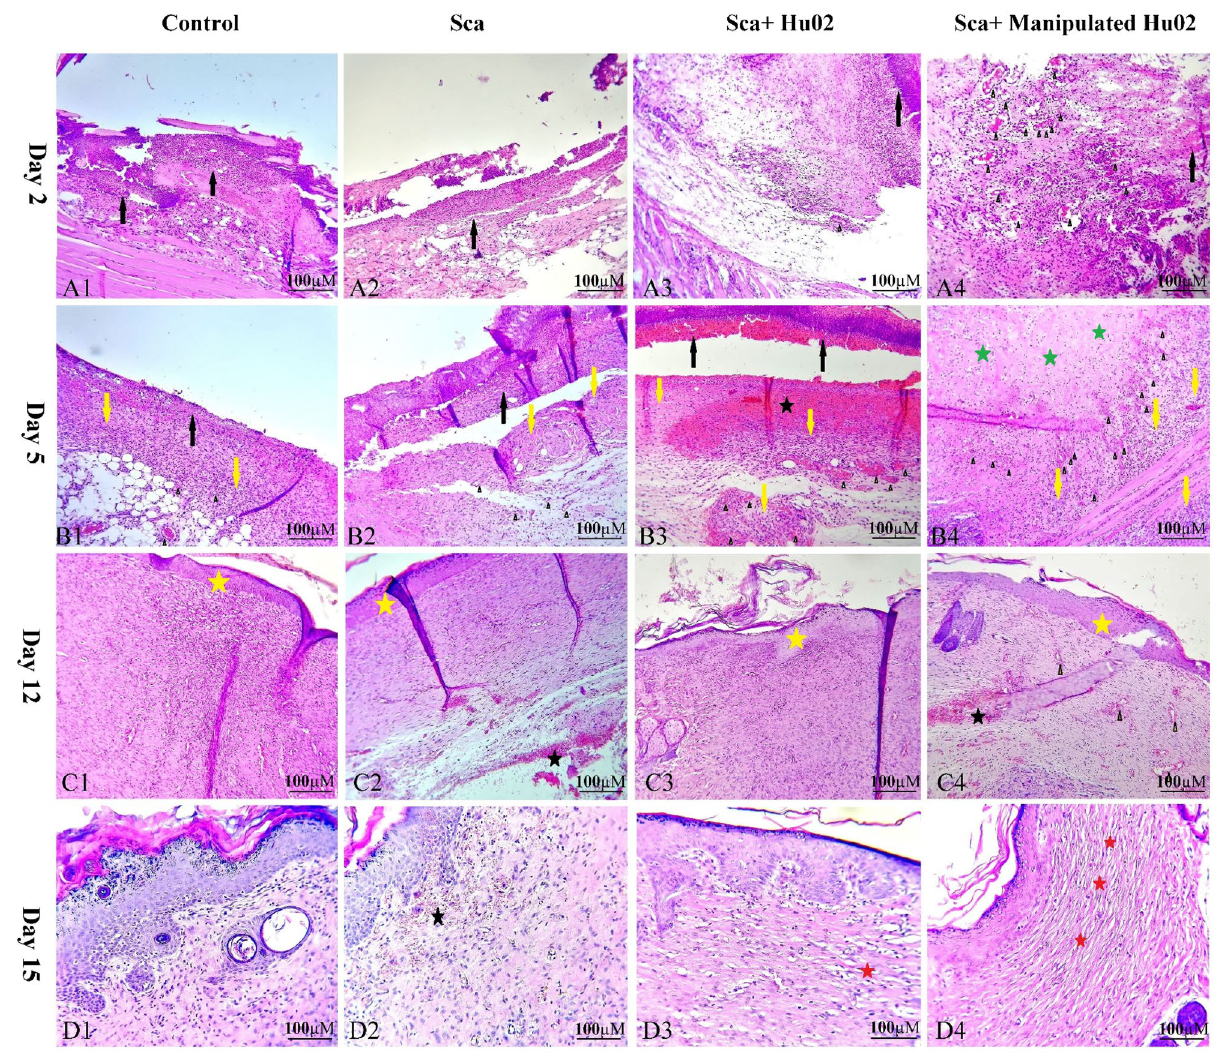
Figure 8. H&E stained microscopic sections of wounded tissue on different days after surgery for Ctrl, Sca, Sca + Hu02, and Sca + Manipulated Hu02 groups. ( A1 )–( A4 ): Day 2 after surgery. ( A1 ) and ( A2 ): Tissue necrosis with high neutrophil infiltration (black arrow) and no angiogenesis. ( A3 ): Tissue necrosis with high neutrophil infiltration (black arrow) and with mild angiogenesis as few formation of new blood vessels (arrow head). ( A4 ): Tissue necrosis with mild neutrophil infiltration (black arrow) and remarkable angiogenesis (arrow head). ( B1 )–( B4 ): Day 5 after surgery. ( B1 ) and ( B2 ): Tissue necrosis with neutrophil infiltration (black arrow), mild angiogenesis (arrow head), mild fibroproliferation, and new connective tissue formation (yellow arrow). ( B3 ): Tissue necrosis with neutrophil infiltration (black arrow), moderate angiogenesis (arrow head), hemorrhage (black star), high fibroproliferation, and new connective tissue formation (yellow arrow). ( B4 ): Remarkable angiogenesis (arrow head), moderate fibroproliferation (yellow arrow), and new connective tissue formation and collagen deposition (green stars). ( C1 )–( C4 ): Day 12 after surgery. ( C1 ): Reepithelialization (yellow star) and increased connective tissue. ( C2 ): Reepithelialization (yellow star), increased connective tissue, and some area of hemorrhage (black star). ( C3 ): Reepithelialization (yellow star) and increased connective tissue. ( C4 ): Reepithelialization (yellow star), increased connective tissue, and some area of hemorrhage (black star). Granulation tissue and angiogenesis (arrow head) were present in some areas. ( D1 )–( D4 ): Day15 after surgery. ( D1 ): Reduction of fibroproliferation. ( D2 ): Reduction of fibroproliferation and the presence of subepidemal hemorrhage (black star) in some area. ( D3 ): Reduction of fibroproliferation and beginning of scar tissue formation (red star). ( D4 ): Reduction of fibroproliferation and remarkable scar tissue formation as large parallel bundles (red